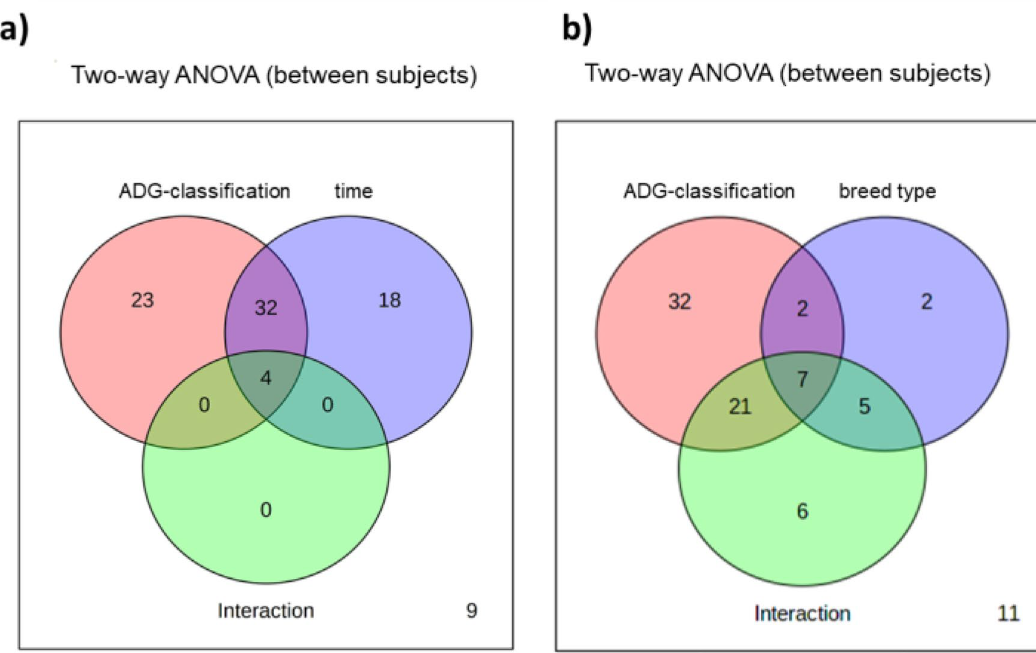
Figure 2. Two-way ANOVA analysis results showing different number of metabolites that have significant P -value (< 0.05) in time ( a ), breed type ( b ), ADG-classification, or the interaction of both variables.